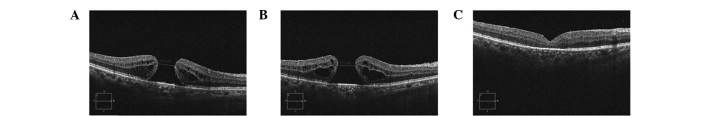
Serial OCT scans showing a patient with a stage IV macular hole. (A) Preoperative OCT line scan demonstrates a full-thickness macular hole. (B) 2 DD of the ILM centered on the macular hole was peeled in the first PPV and the macular hole did not close. (C) ILM peeling for the secondary surgery was enlarged to the vascular arcades of the posterior fundus and the macular hole was closed. OCT, optical coherence tomography; DD, disc diameter; ILM internal limiting membrane; PPV, pars plana vitrectomy.